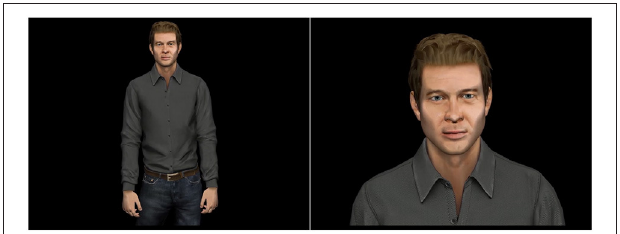
FIGURE 7 | Still image of full-body (left) and head-only (right) video used in the passive experiment.